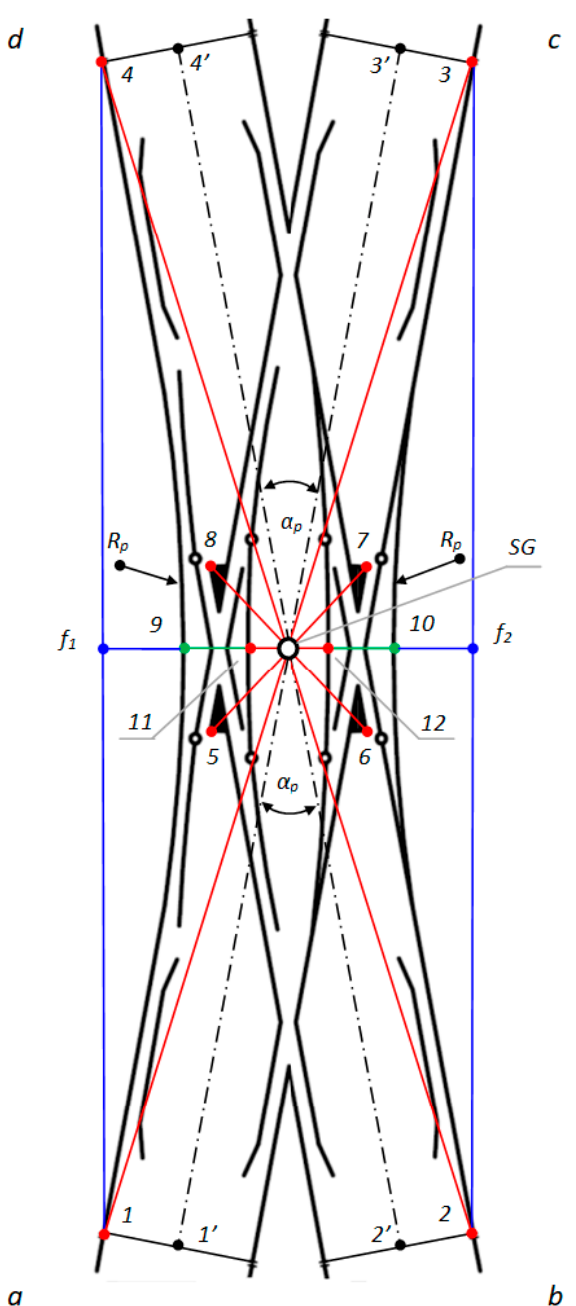
Figure 2. Double slip turnout of Rkpd iwew with blades inside the quadrilateral of the turnout using the Surveying and Monitoring of the Geometric Center of a Double and Outside Slip Turnout (SMDOST) method.